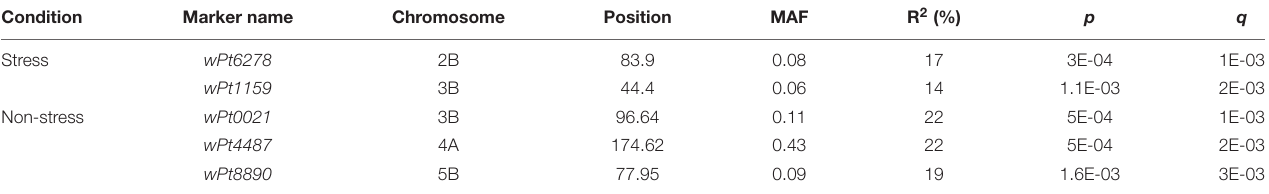
TABLE 3 | Significant root length QTLs, associated DArT markers, their chromosomal positions, and level of phenotypic variation (r 2 ) explained by each of the QTLs. Condition